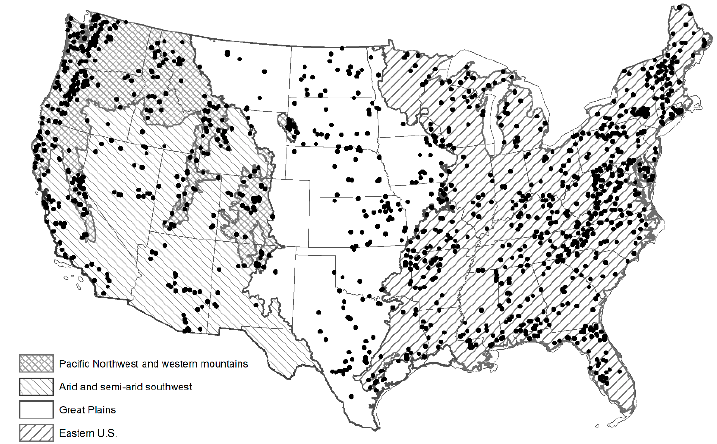
Figure 1. Locations of 1331 U.S. Geological Survey streamgages used as validation sites, and regions used for grouping study results.